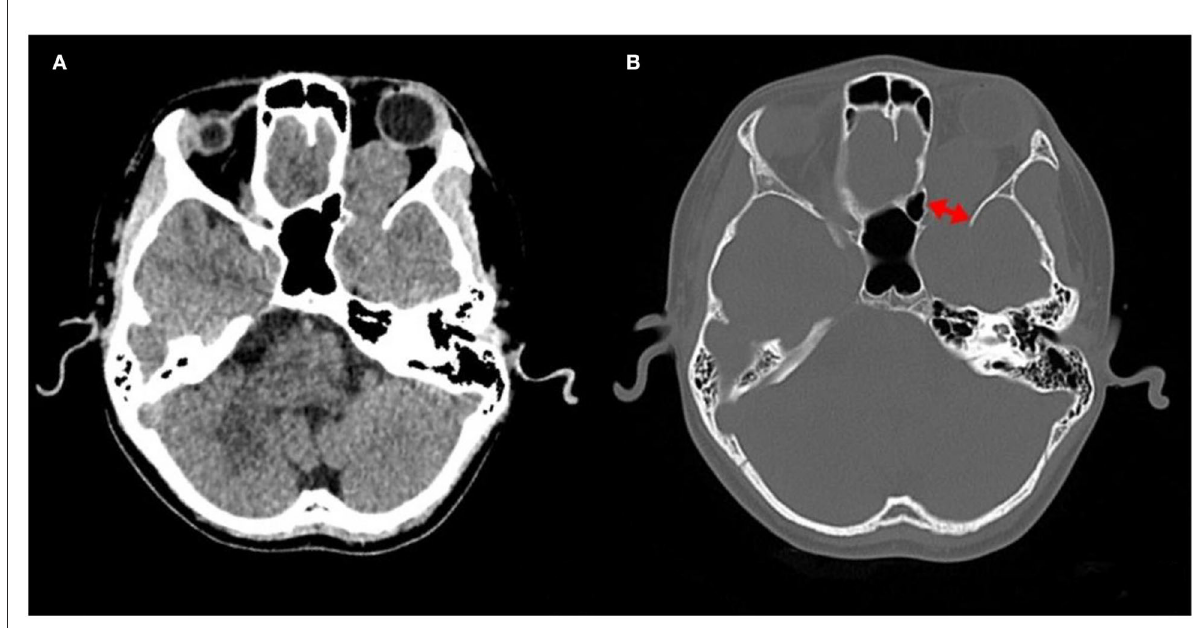
FIGURE1 Images of computed tomography (CT). (A) CT revealing a mass in orbit, some of which seem to extend into the cranial cavity. (B) The bone window showing compressive displacement of the adjacent bone and widened supraorbital fissure (two-way